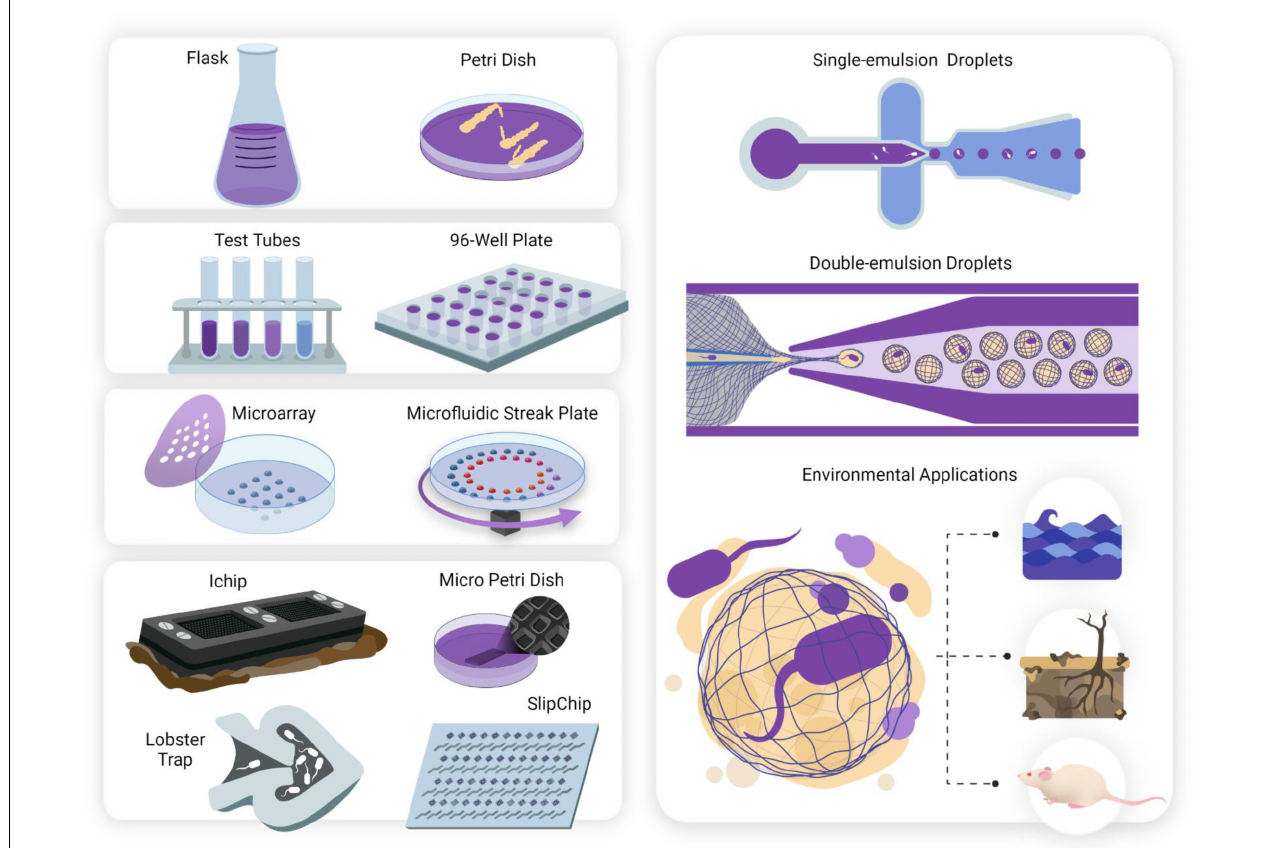
FIGURE 1 | The miniaturization of cell culturing techniques has revolutionized single-cell studies for culturing microorganisms deemed “unculturable.” Conventional culturing methods (mL—L). Anaerobic jars, flasks and Petri dishes have been used since they were first developed in the 1800s and still form the basis for traditional cell culturing today. Serial dilutions and microwell plates ( µ L—mL). These mark the first scaling down of culturing techniques and allow for quantification of cell growth and automated screening . Microarray technologies (nL— µ L). Microarray printing of droplets allows for highly automated single-cell analyses and investigation of metabolic enzymatic reactions. Two examples include the Microbe Observation and Cultivation Array (MOCA) (Gao et al., 2013) and the Microfluidic Streak Plate (MSP) (Jiang et al., 2016). Micromachined devices (nL— µ L). Micromachined devices make use of microfabrication techniques to design devices containing microwells or chambers for cultivating and screening microbes. Examples of such devices include the ichip (Nichols et al., 2010) micro-Petri dish (Ingham et al., 2007), lobster traps (Connell et al., 2010), and SlipChip (Ma et al., 2014). Microfluidic technologies (pL—nL). Microfluidics offer observations with flow dynamics in microfluidic channels, and isolation and compartmentalization of cells in the form of single (Chang et al., 2015) and double (Niepa et al., 2016) emulsion droplets. Droplets can be aqueous or gel phase (Lin et al., 2011), offering tunable constraints for study design. Culturing the “unculturable”- from macroscale to nanoscale. Untapped potential lies awaiting exploration in microbiomes such as marine, animal and soil systems. Discoveries of novel species may influence drug discovery, human health and other fields including bioremediation and